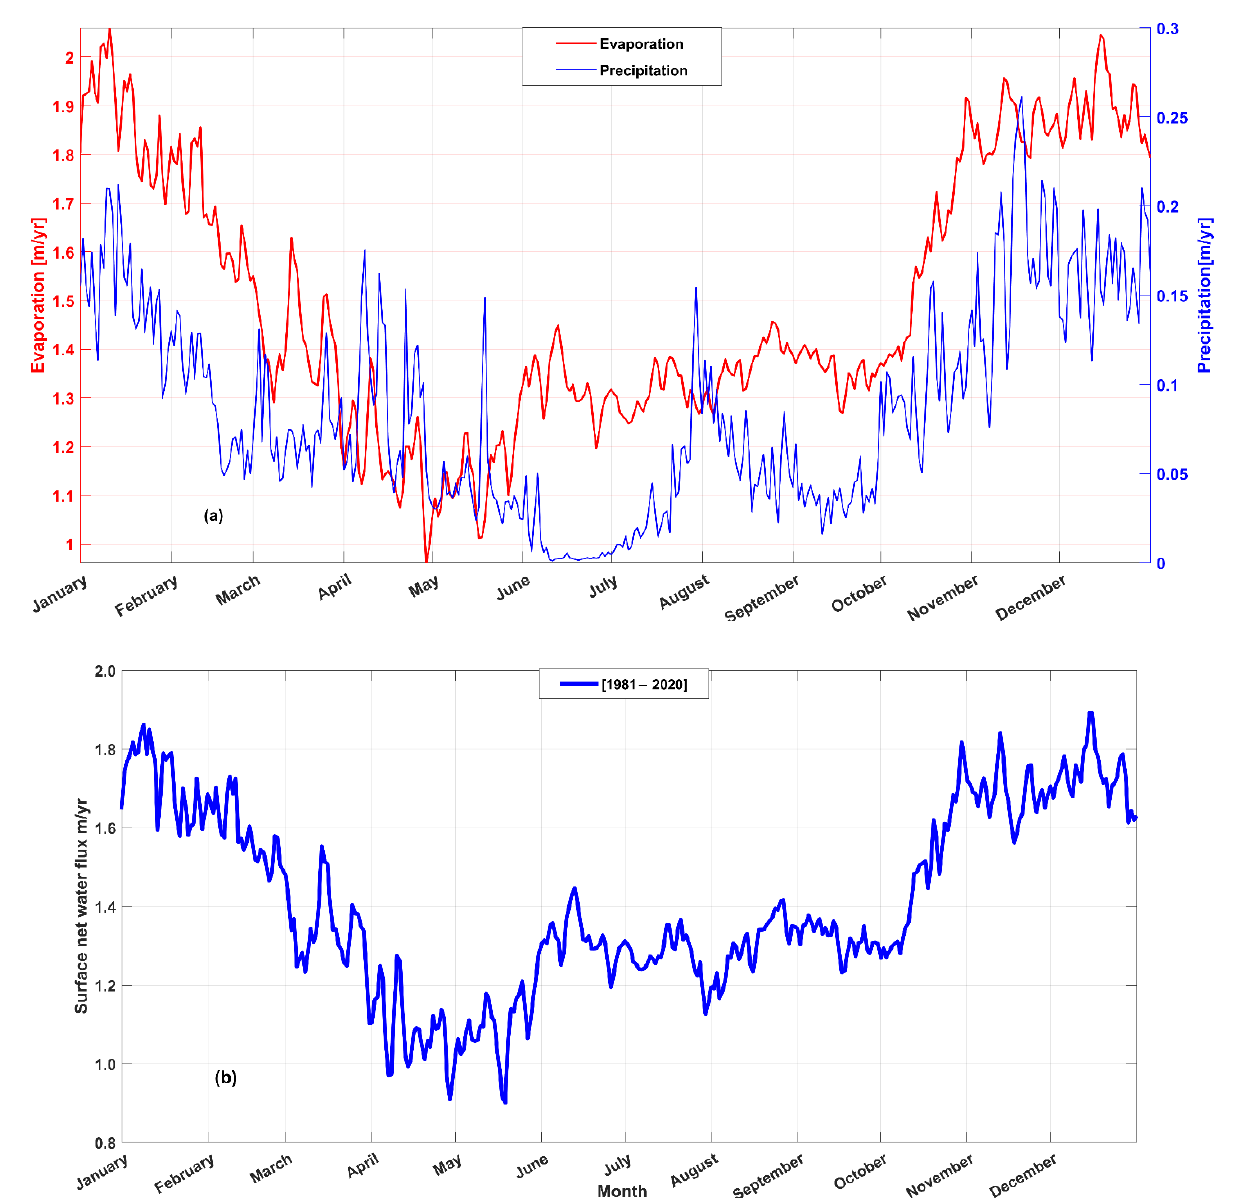
Figure 7. ( a ) Temporal evolution of the daily basin averaged evaporation (E) m/yr in red line (left y -axis and precipitation (P) m/yr in blue line (right y -axis) from 1981 to 2020 for the whole Red Sea. ( b ) Temporal evolution of the daily basin averaged surface net water flux (m/yr) from 1981 to 2020 for the Red Sea.